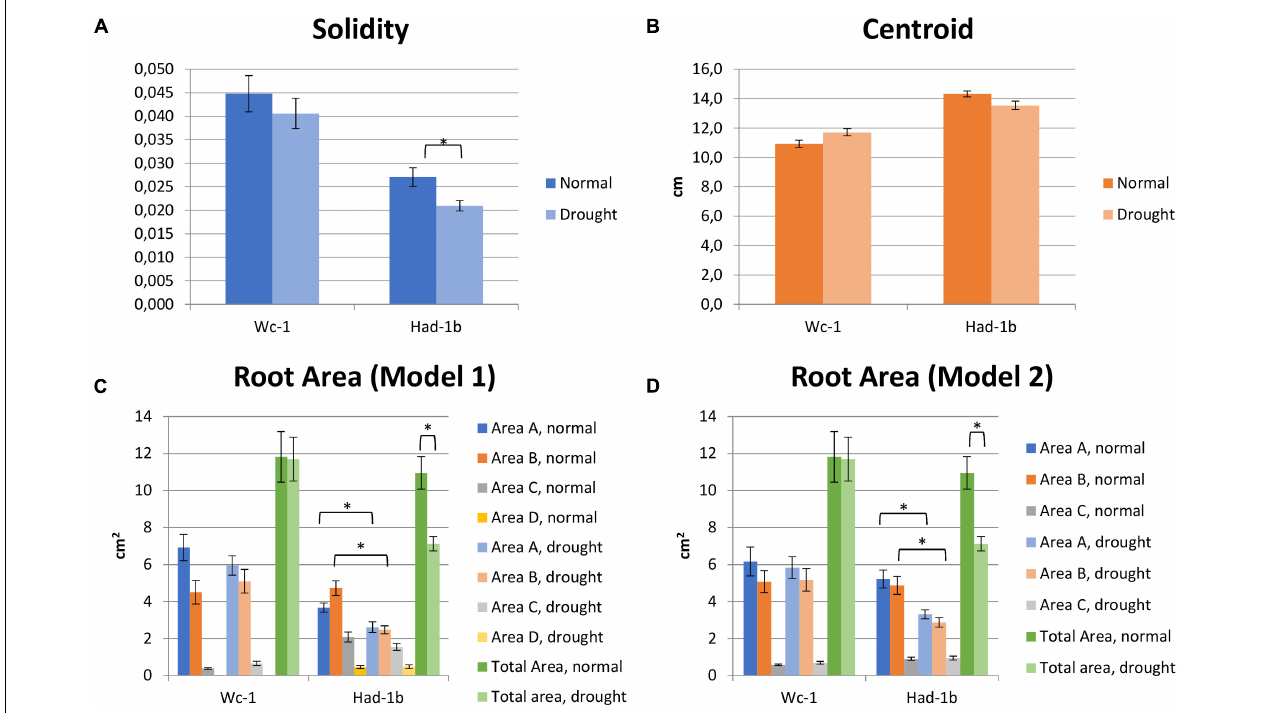
FIGURE 5 | (A–D) Results of measurements of RSA traits including root area in the zones of the rhizosheets, for two contrasting accessions. *, p < 0.05 as analyzed by a Student’s t -test.